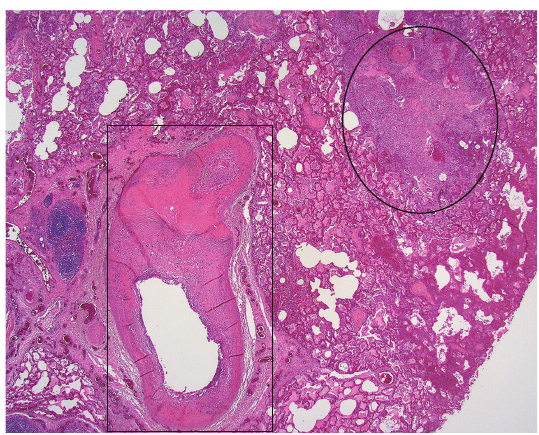
Figure 5: This section of the lung by autopsy showed a dilated vessel with tumor (intima sarcoma, rectangle) and extravascular extension of the tumor (circle). (Hematoxylin and eosin, ×